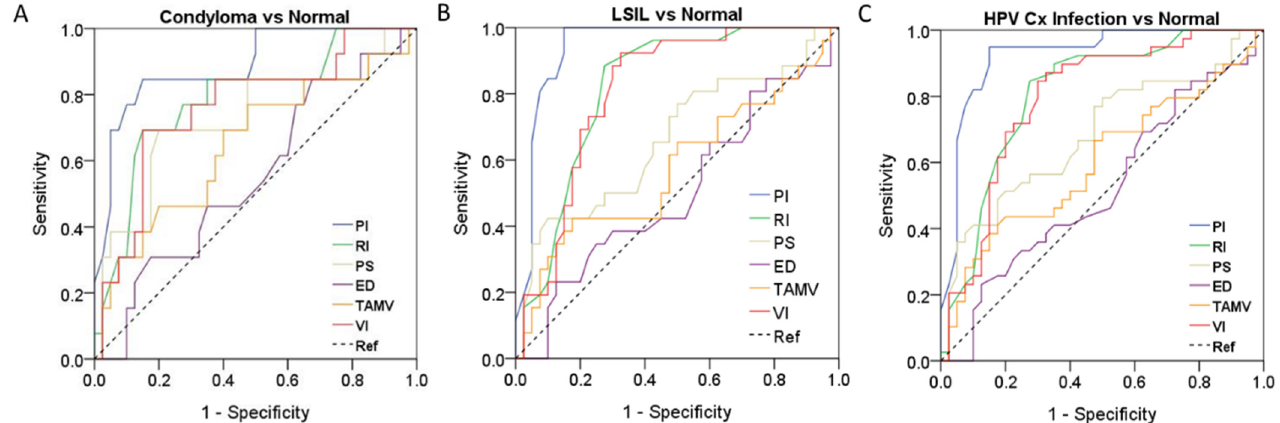
Figure 6. ( A ) ROC curves of the six sonographic parameters for discriminating between HPV condyloma ( n = 13) and the control group ( n = 40), ( B ) LSIL (CIN I) ( n = 26) and the control group ( n = 40), and ( C ) and HPV infection ( n = 39) and the control group ( n = 40). Table 3. Optimal cutoff values of the six sonographic parameters for discriminating (A) HPV condyloma and the control group, (B) LSIL (CIN I) of the cervix and the control group, and (C) HPV infection and the control group.